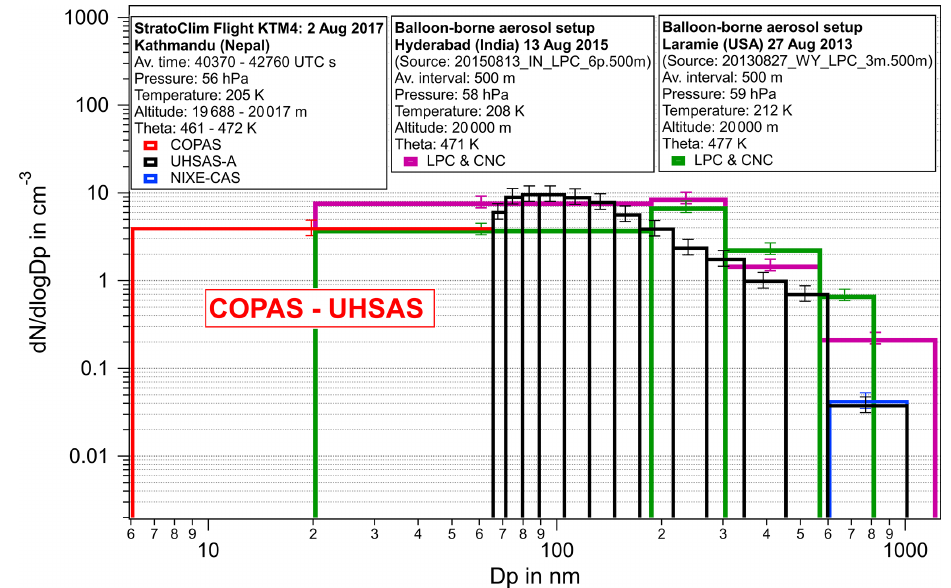
Figure 4. Aerosol particle size distribution combined from the measurements performed by the UHSAS-A, COPAS, and NIXE-CAS (over- lapping size range with the UHSAS-A) for the highest flight level reached during the flight KTM4 of the 2017 StratoClim campaign. The particle number concentrations are given for ambient conditions. The concentration of the size bin marked in red (6 to 65nm) is the difference between the total number concentrations measured by COPAS (diameter range of 6nm to 1µm) and UHSAS-A (diameter range of 65nm to 1µm). Air pressure, temperature, altitude, and potential temperature according to the UCSE data set are also shown. For comparison, measurements of the balloon-borne measurement setup described by Ward et al. (2014) and Campbell and Deshler (2014) for flights from Hyderabad (India) and from Laramie (USA) are shown in purple and green,